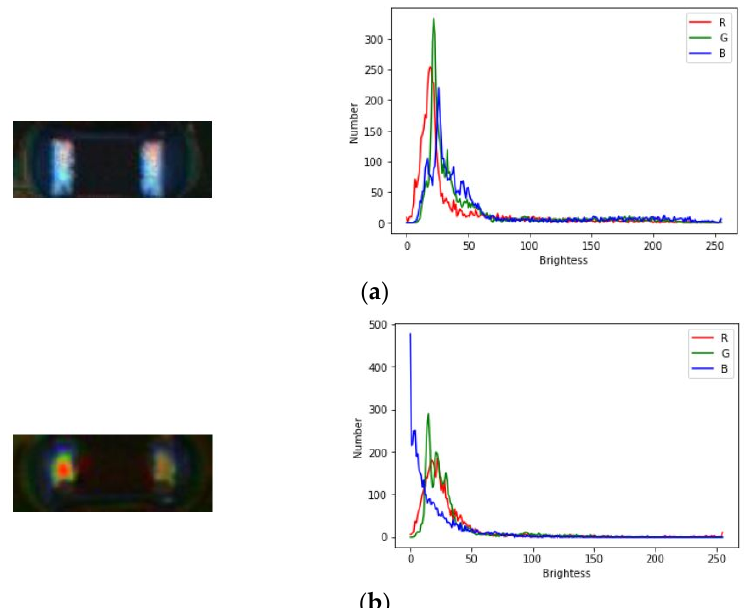
Figure 3. Different image color scales. ( a ) Photograph and RGB values by machine A; ( b ) Photograph and RGB values by machine B.